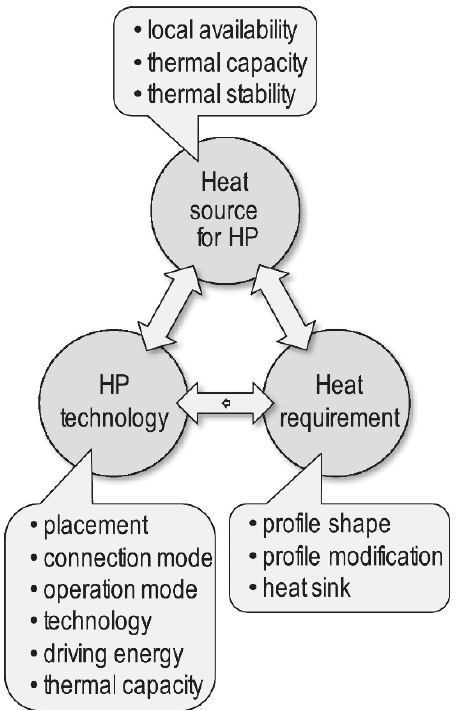
Figure 7. Technical triangle featuring key features for integrating heat pumps in DH [75].